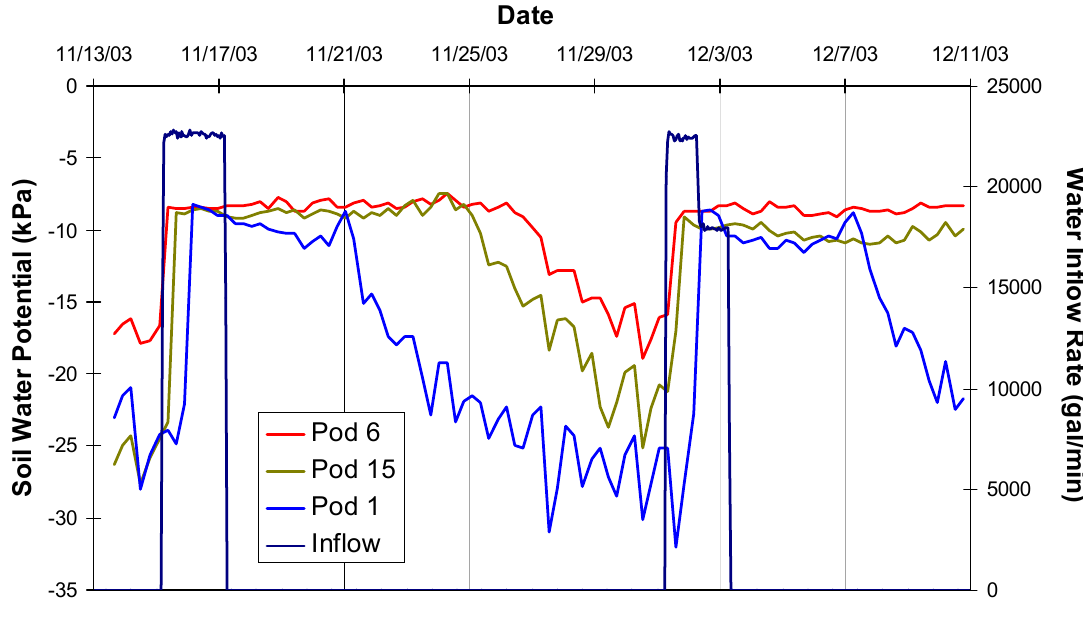
Figure 8. Soil water potential at 0.5 m deep along the west basin border during the first two flooding events after deployment. Traveling from north to south, the pods are positioned: 6 (inlet), 15, and then 1. Also shown is the inlet water